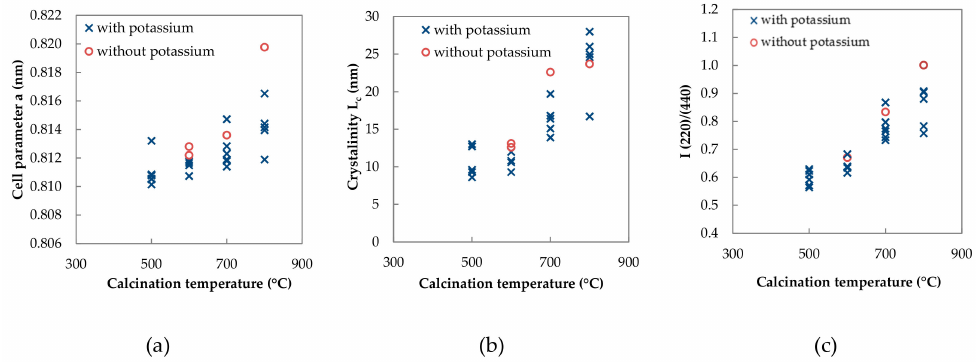
Figure 2. E ff ect of calcination temperature on ( a ) spinel lattice parameter a , ( b ) coherent domain size L c and ( c ) I (220) / (440) intensities ratio.